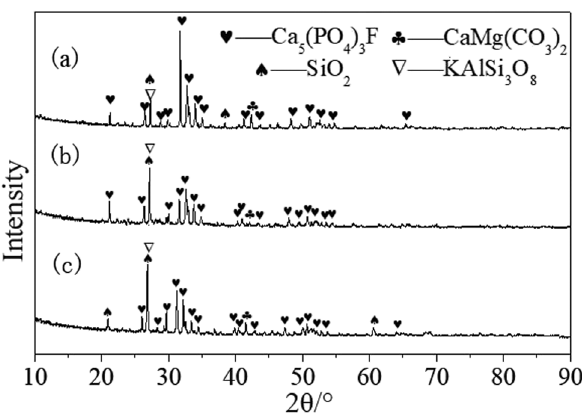
Figure 1: XRD pattern of three types phosphate rock: ( a ) Mabian, ( b ) Huangmailing, and ( c )